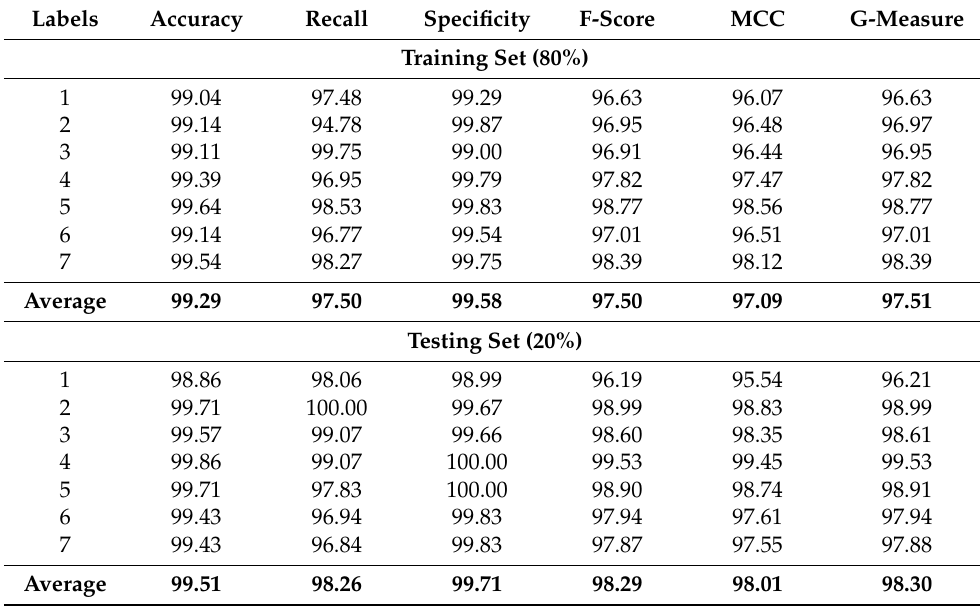
Table 2. Result analysis of the CL-DLBIDC approach with distinct measures under 80:20 of TR/TS data.